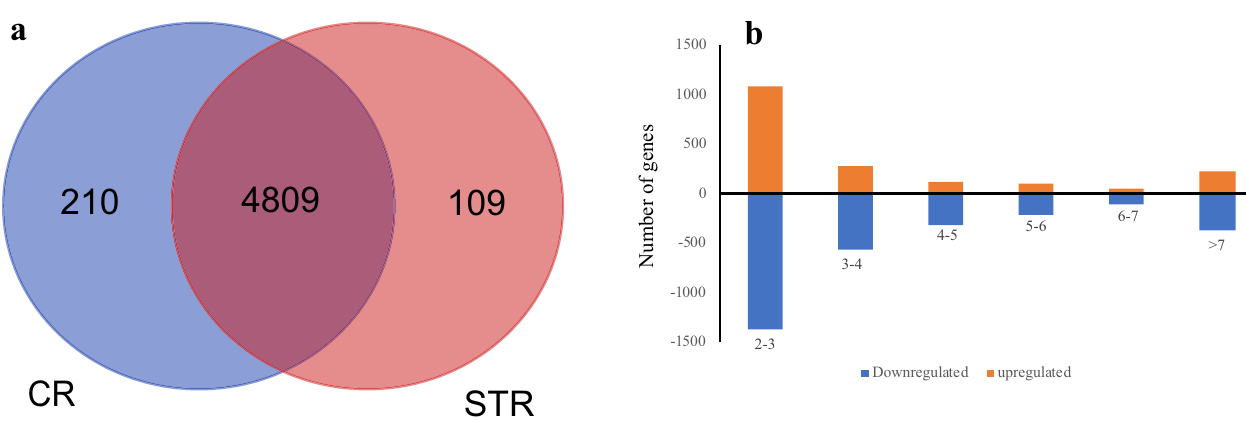
Fig 1. Survey of differentially expressed genes (DEGs) between control and salt stress in bread wheat. (Cut off pvalue: 0.01). (a) Out of 5128 DEGs, 109 genes were uniquely expressed in control and 210 genes were uniquely expressed under salt stress (b) Fold change distribution of 4809 DEGs available in both